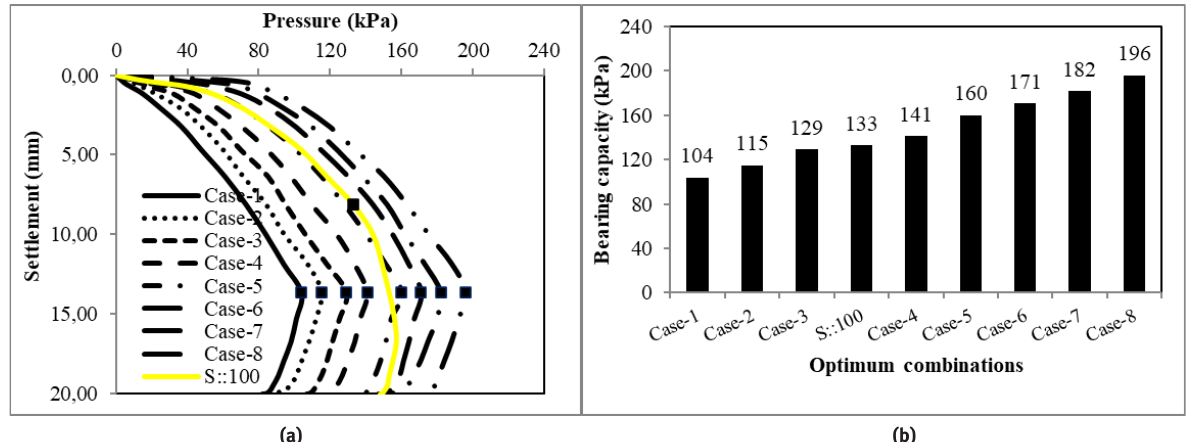
Figure8:(a) Pressure–settlement curves and (b) ) bearing capacity values of two-layered soil for all cases at h/B=1.225 and single-layer sandy soil for